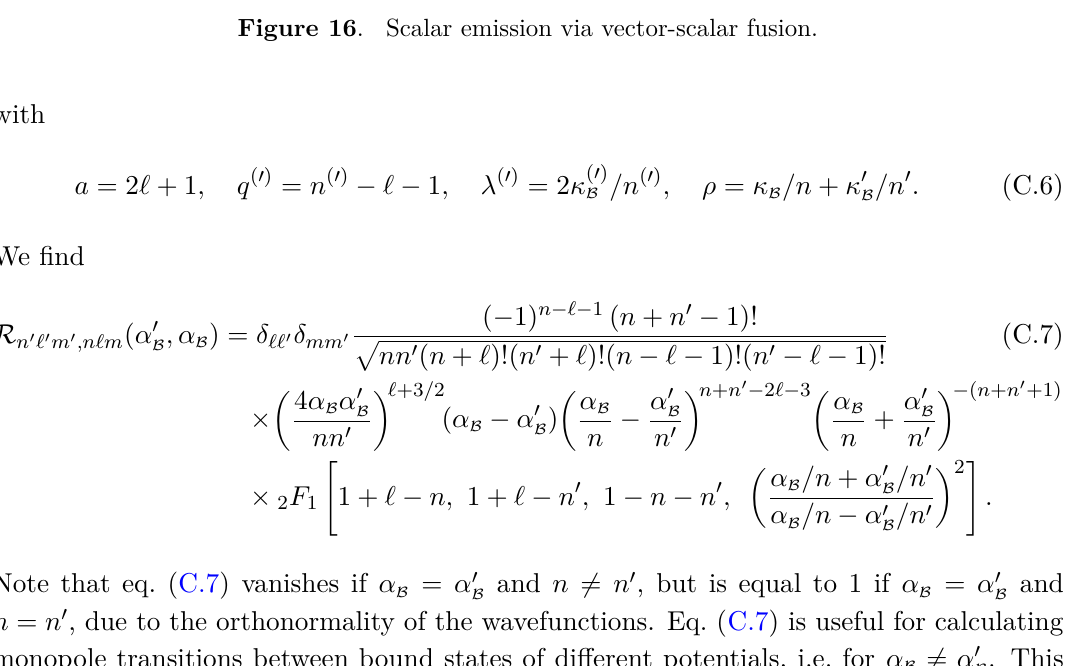
Figure 16 . Scalar emission via vector-scalar